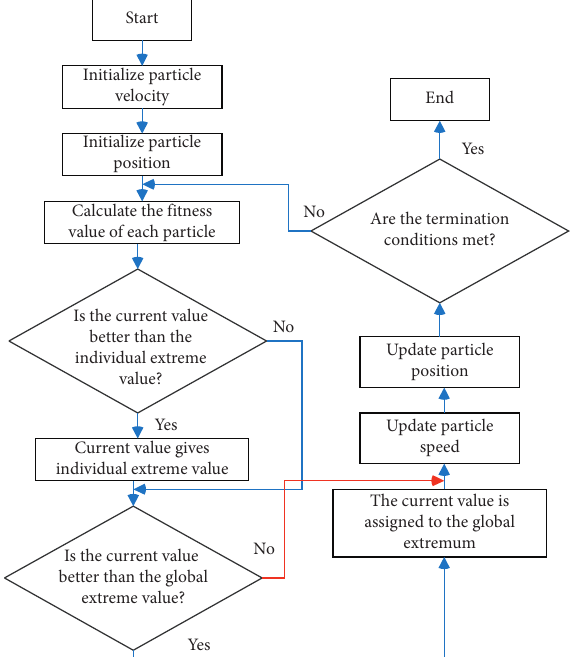
Figure 3: Flow chart of single waveform measurement of water microbial concentration monitoring